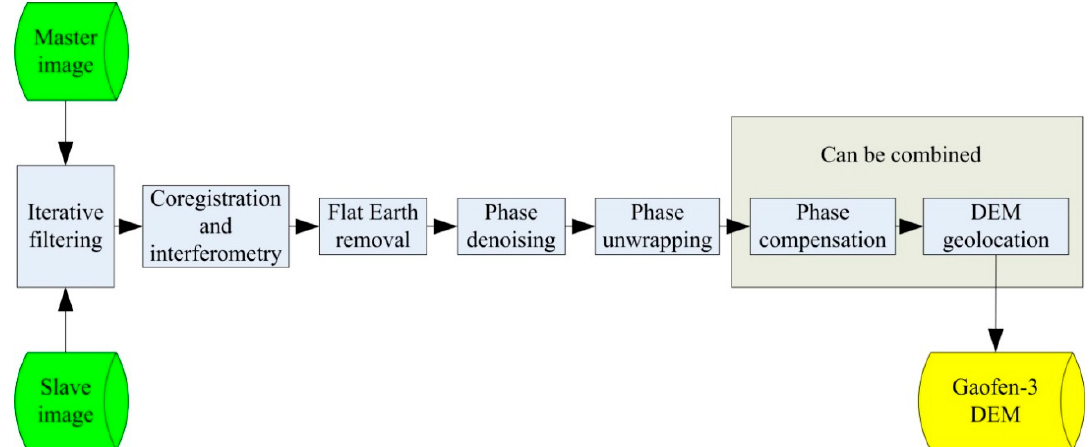
Figure 2. The interfeometric processing diagram. DEM: digital elevation model.